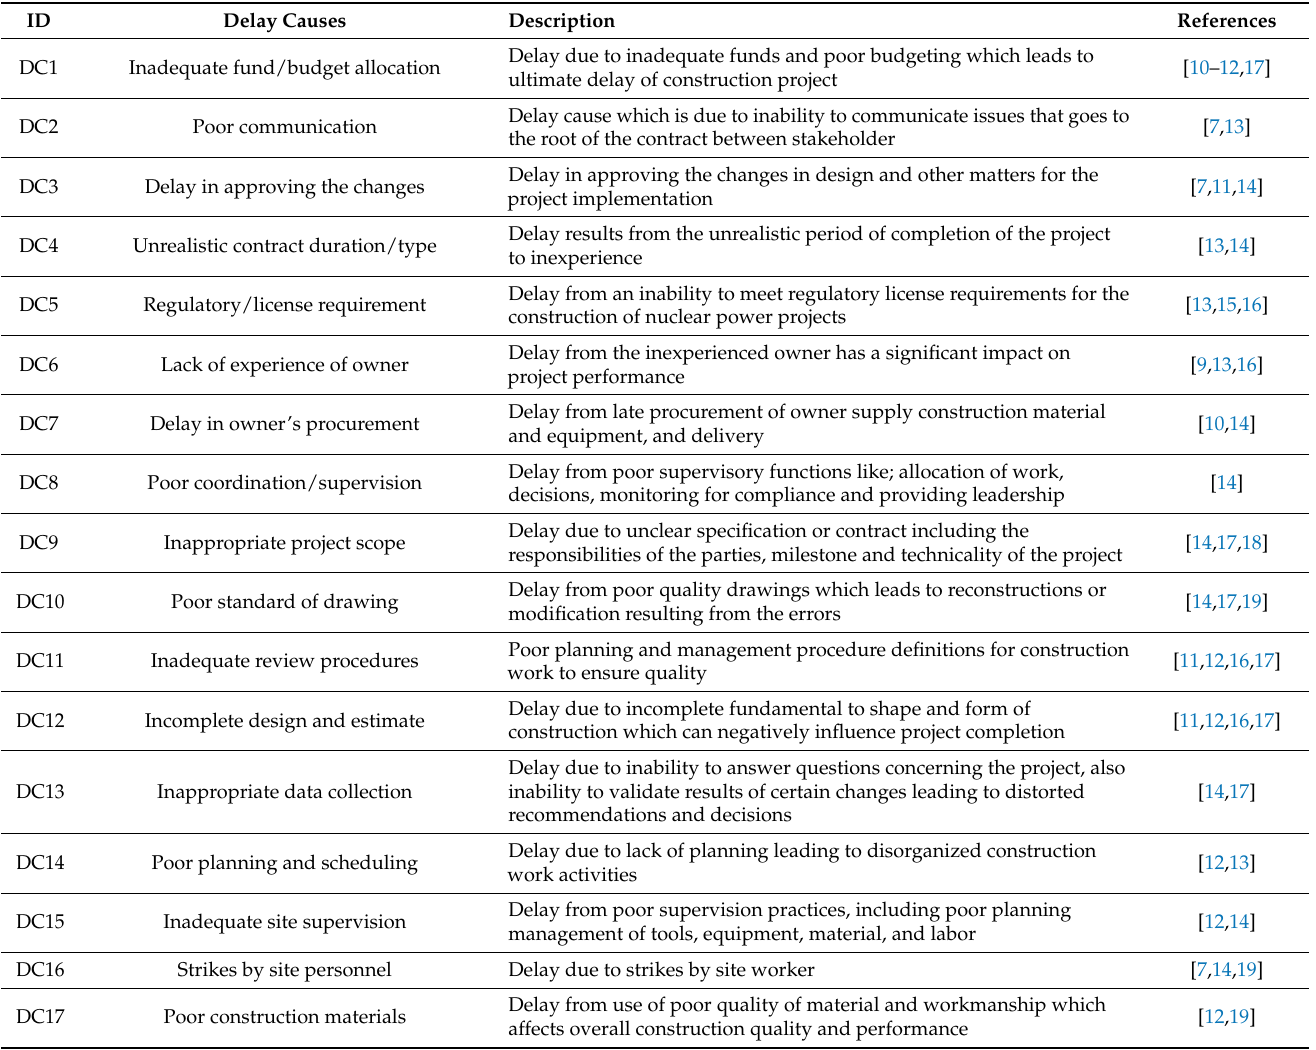
Table 1. Delay causes identified in previous